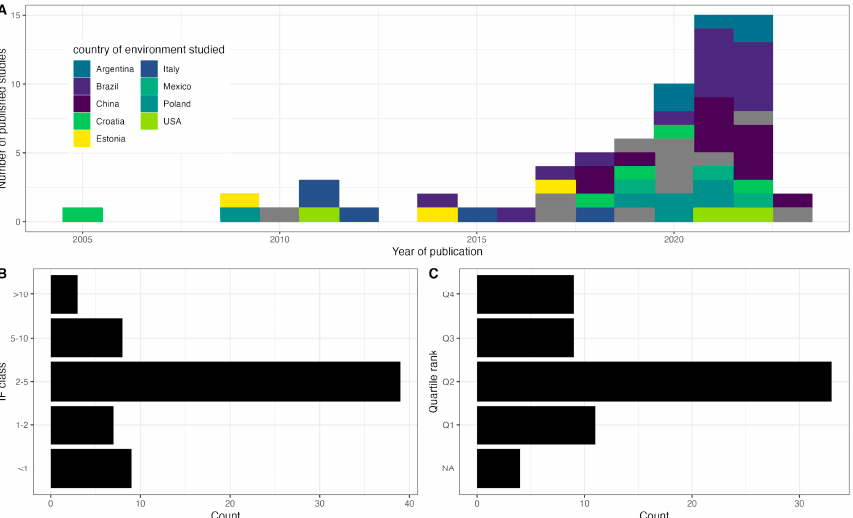
Figure 1. Articles on rotifer functional diversity: ( A ) Country of environment studied; the countries with at least three published studies are shown; grey color refers to countries with < 3 published studies; ( B ) number of studies binned by IF classes; ( C ) number of studies binned by the quartile rank; NA refers to studies with no IF.